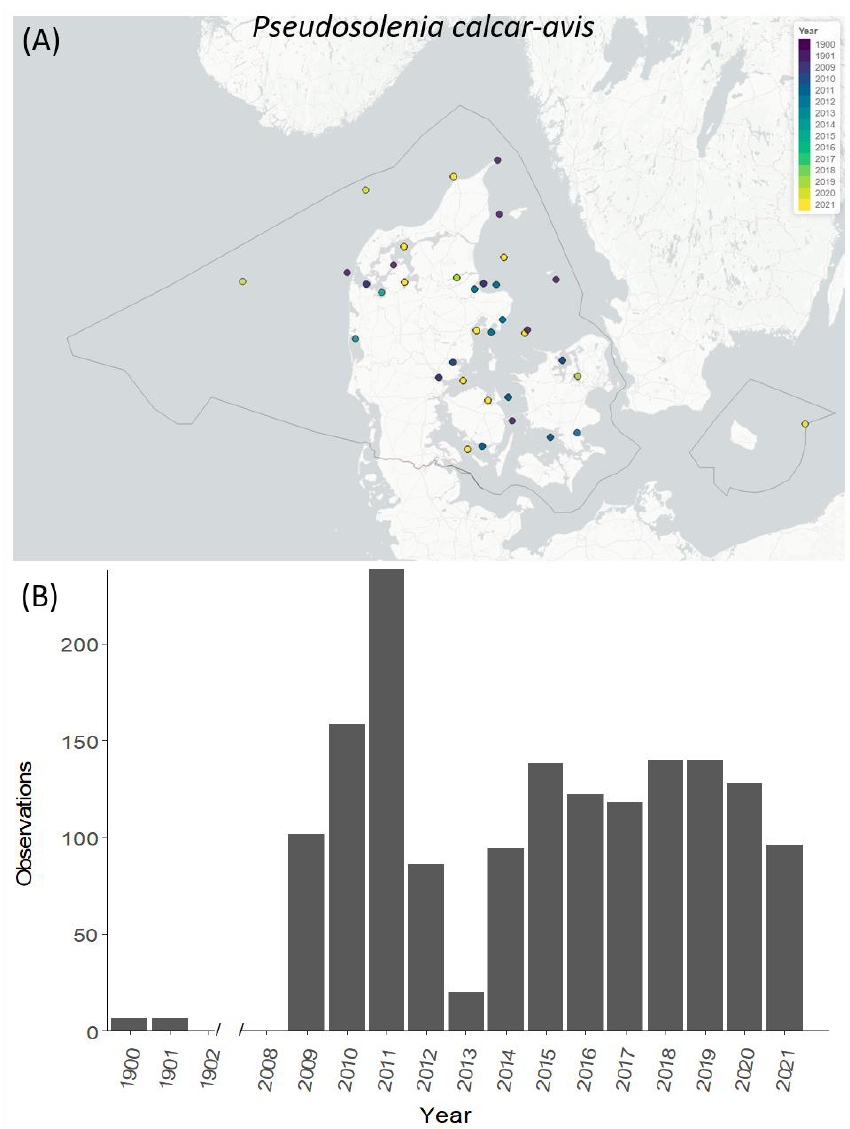
Figure 7. Pseudosolenia calcar-avis . ( A ) Map of sampling stations with known occurrences since 2009 within the Danish EEZ; ( B ) number of annual observations. Data from 2009 were obtained from the Danish National Monitoring Program (NOVANA) (Supplementary Table S2). Data from 1900 and 1901 are from [95].